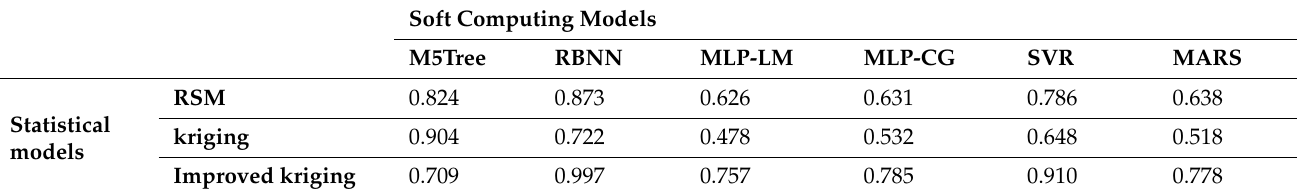
Table 8. p -Values of the Mann–Whitney Test for statistical methods versus soft computing models in Antakya Station.